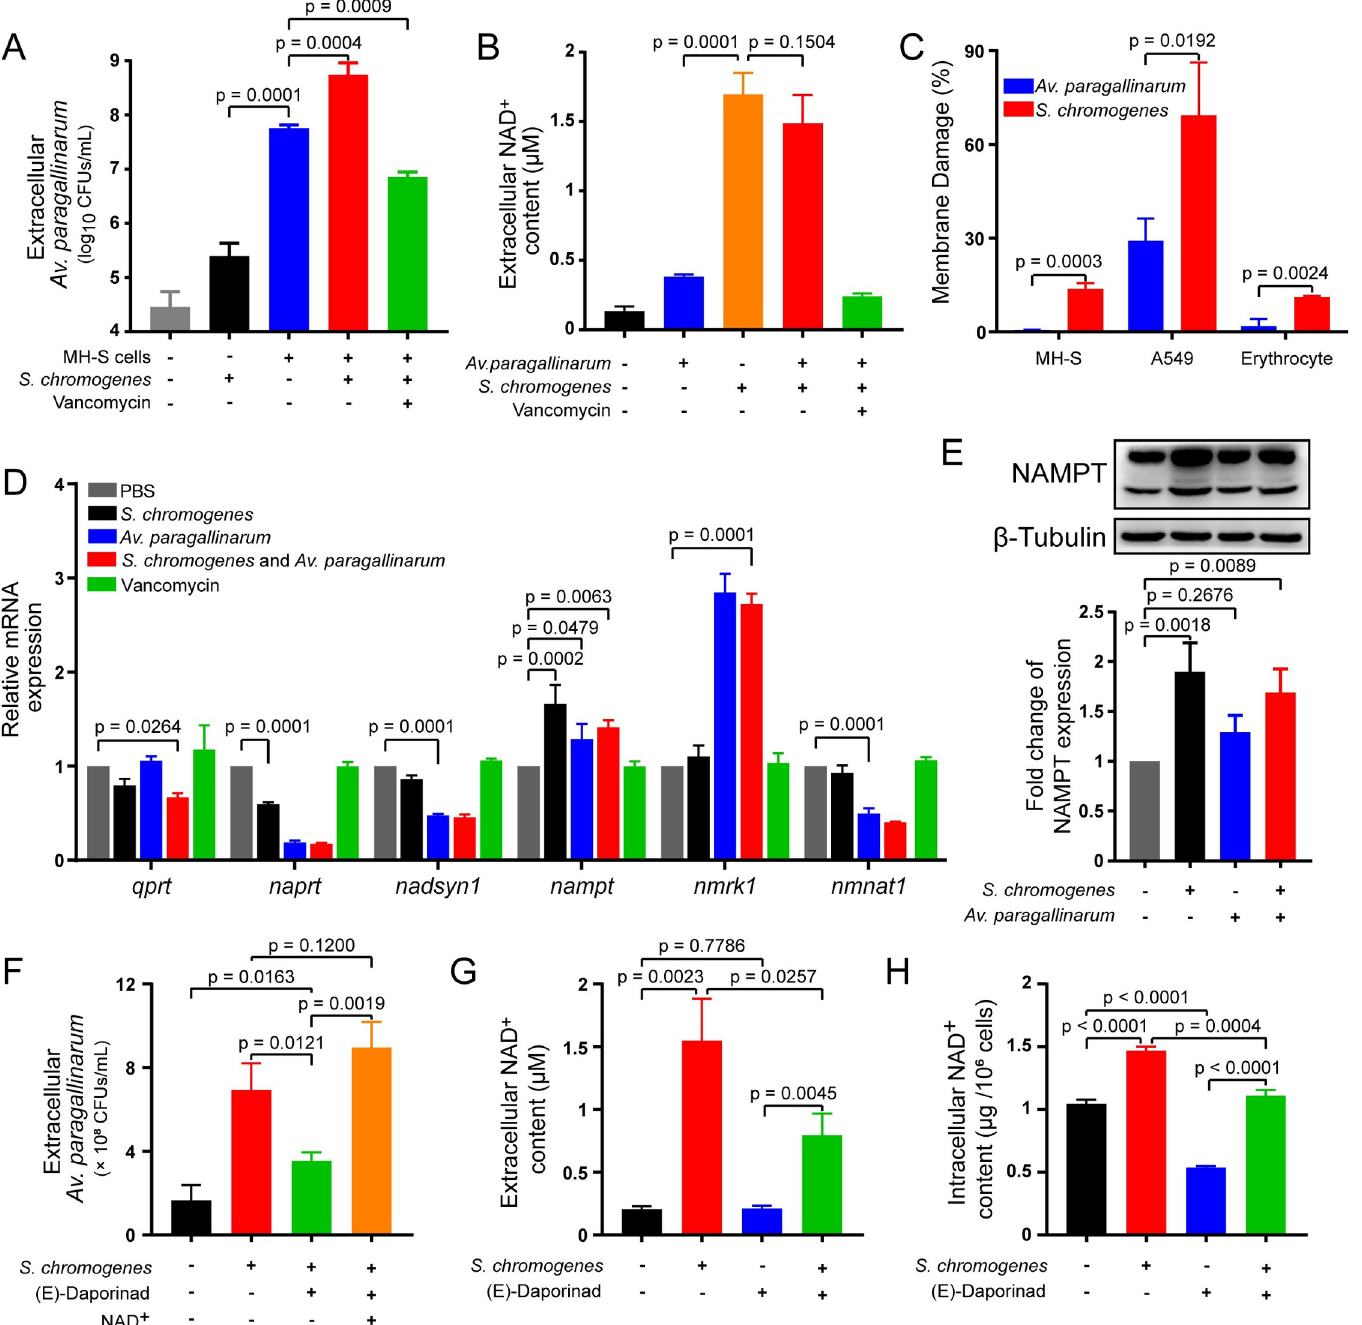
Fig 6. S . chromogenes hijacks host cells to promote the growth of Av . paragallinarum . (A) S . chromogenes increased the number of extracellular Av . paragallinarum . MH-S cells were infected with S . chromogenes SC10 and Av . paragallinarum X1-1S-1 (MOI = 1) and treated with 10 μ g/mL vancomycin for 6 h. (B) S . chromogenes promoted NAD + release from the host cells. MH-S cells were treated the same as in (A). (C) S . chromogenes seriously damaged the membrane of mammalian cells. MH-S and A549 cells were infected with S . chromogenes SC10 (MOI = 1) for 6 h, and erythrocytes were coincubated with S . chromogenes (10 6 CFUs/mL) in PBS for 6 h. (D) The mRNA expression of NAD + synthetases. MH-S cells were infected with S . chromogenes SC10 and/or Av . paragallinarum X1-1S-1 (MOI = 1) or incubated with 10 μ g/mL vancomycin for 6 h. (E) S . chromogenes promoted the expression of NAMPT. A549 cells were infected with S . chromogenes SC10 and/or Av . paragallinarum X1-1S-1 (MOI = 1) for 6 h. (F) The NAMPT inhibitor (E)-daporinad reduced the number of Av . paragallinarum . MH-S cells were infected with S . chromogenes SC10 and Av . paragallinarum X1-1S-1 (MOI = 1) and treated with 1 μ M (E)-daporinad and/or 10 μ g/mL exogenous NAD + for 6 h. (G, H) S . chromogenes increased the content of extracellular or intracellular NAD + . MH-S cells were infected with S . chromogenes (MOI = 1) and/or treated with 1 μ M (E)-daporinad for 6 h. P values were determined by one-way ANOVA (A, B, D and E) and unpaired t -test (C, F, G and H). The mean of three biological replicates is shown, and error bars represent the standard deviation (SD) (n = 3).